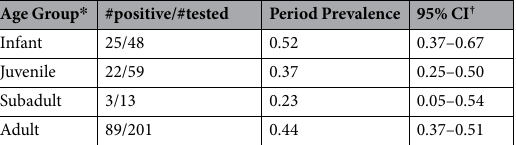
Table 1. Mountain gorillas ( Gorilla beringei beringei ) from the Virunga Massif and Bwindi Impenetrable Forest shedding mountain gorilla-specific lymphocryptovirus-1 (GbbLCV-1) between November 2012 and June 2013 by age class. * Infants were defined as gorillas less than 3 years of age, juveniles as 3 to 5 years of age, subadults as